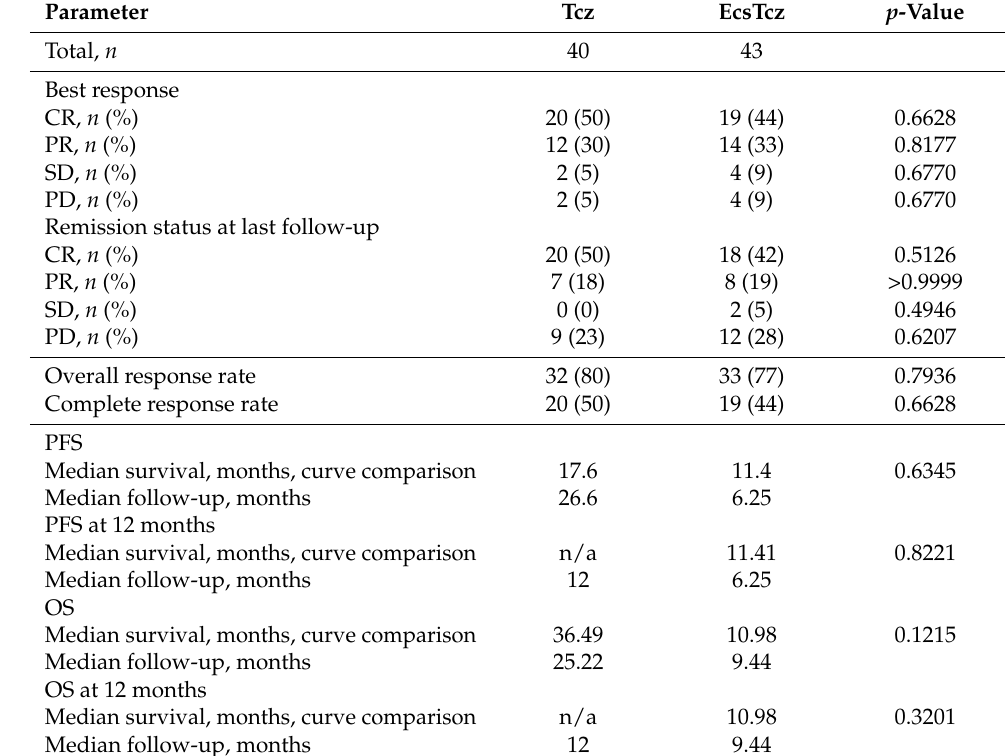
Table 5. Comparison of outcomes of CAR T-cell therapy in the Tcz vs. EcsTcz cohorts.